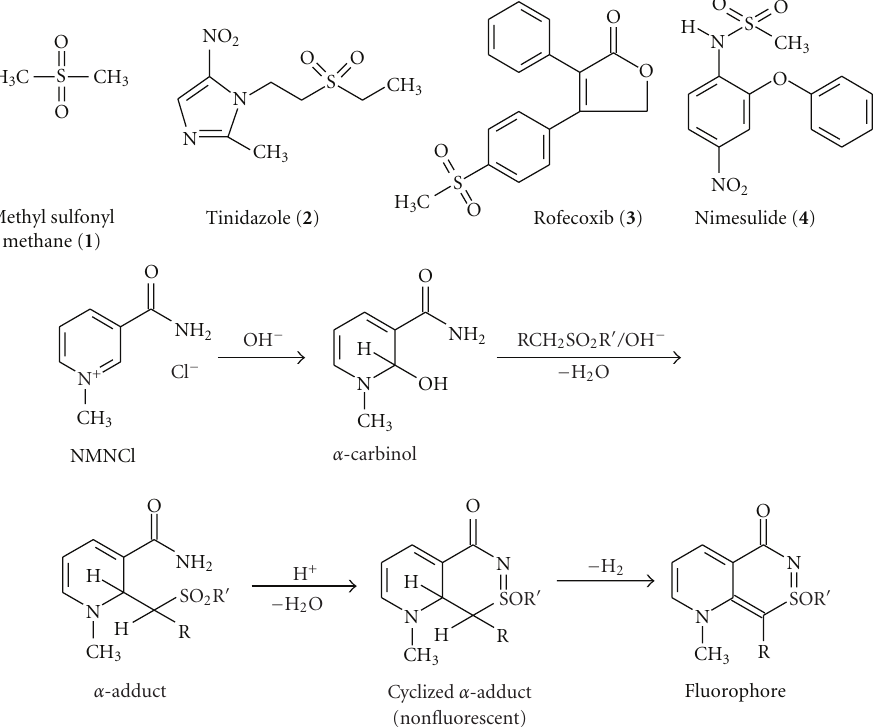
Figure 1: Chemical structures of the analytes and plausible pathway for the reaction of NMNCl with α -methylene sulfone/sulfonamide functional groups of 1–4 .